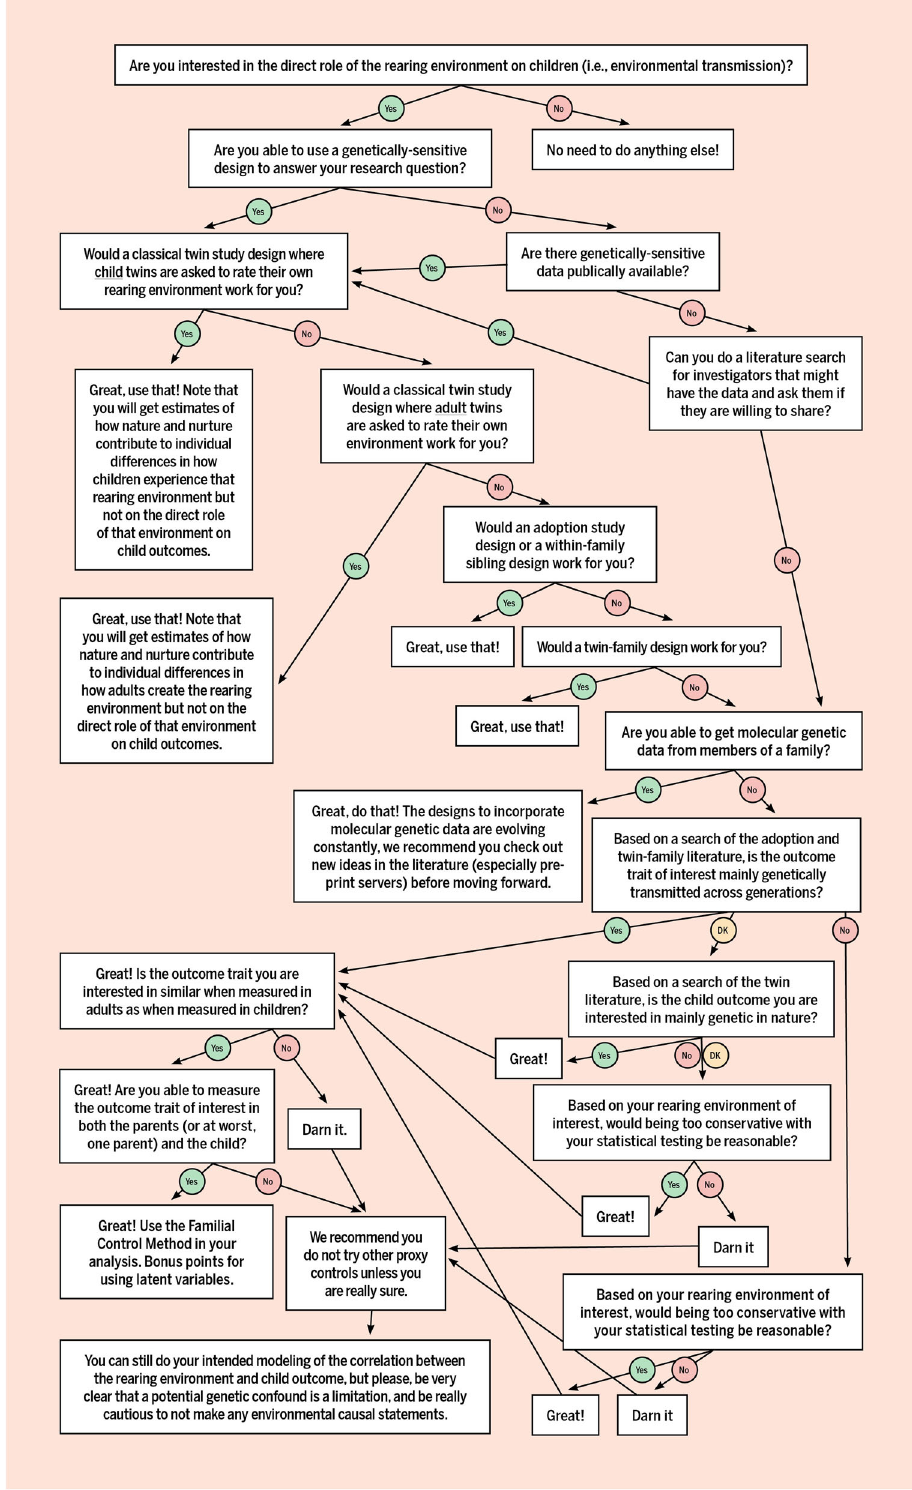
Fig. 9 Decision fl owchart for determining how to control for genetic confounding when examining the rearing environment. DK = don ’ t know. Figure by ref. 66 available at https://bit.ly/3gkM6Et under a CC BY 4.0